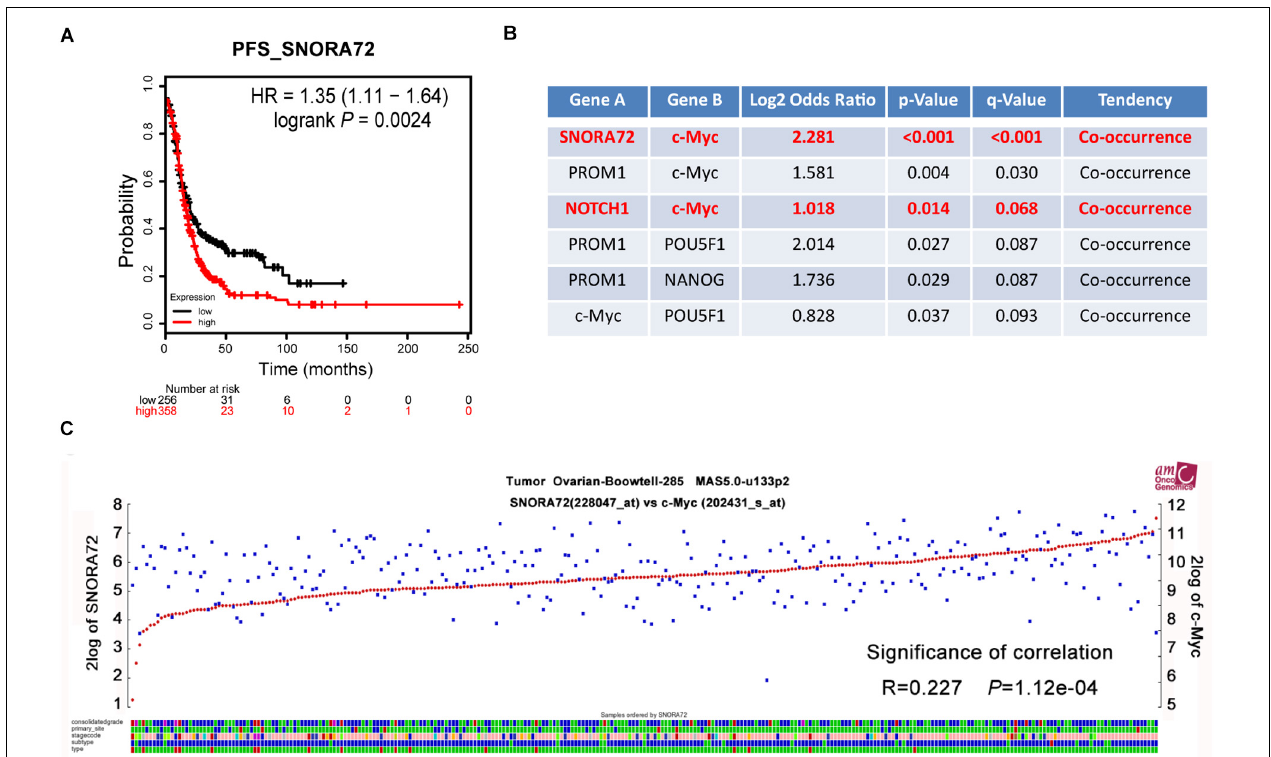
FIGURE 5 | SNORA72 expression is positively associated with the c-Myc expression of ovarian cancer patients. (A) Online tool Kaplan–Meier Plotter used to analyze the relationship between SNORA72 expression and the progression-free survival (PFS) of ovarian cancer patients. (B) The relationship between SNORA72 expression and stemness markers was analyzed by the online analysis website cBioPortal. (C) R2: Genomics Analysis and Visualization Platform used to analyze the expression correlation between SNORA72 and c-Myc.